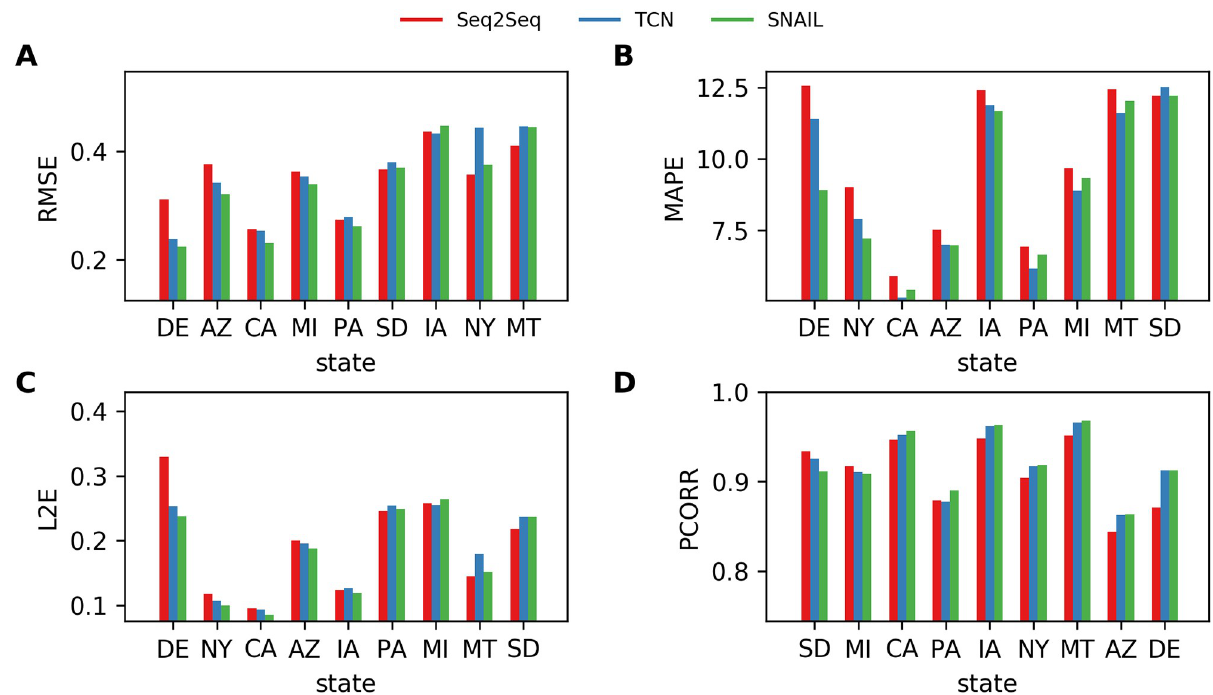
Fig 11. The best performances achieved by Seq2Seq, TCN, and SNAIL for one-week-ahead forecasts. A. RMSE, B. MAPE, C. L2E, and D. PCORR. Four performance metrics, RMSE, MAPE, L2E, and PCORR, are measured for each state. In the horizontal axis, the states are placed in a decreasing order w.r.t. the relative performance of SNAIL against Seq2Seq. Results of the nine selected states, {AZ, CA, DE, IA, MA, MT, NY, PA, SD} are depicted.